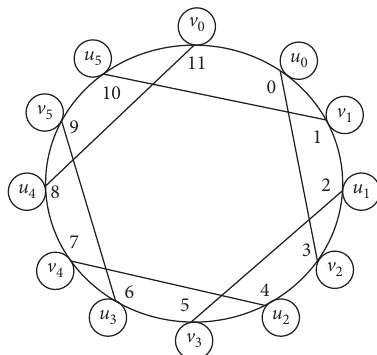
Figure 2: The chordal ring network CR